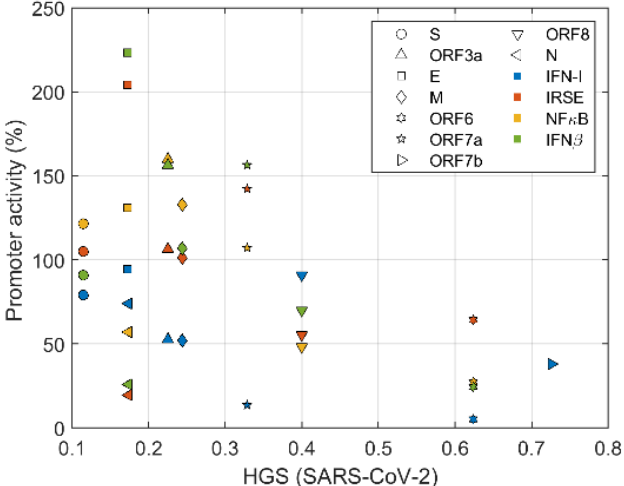
Figure 9. The SARS-CoV-2 escapes innate immunity by suppressing the expression of IFN- β , IFN-I, ISRE (indicating interferon synthesis) and NF κ B through ORF encoding accessory proteins. As the HGS of viral genes increase, the activity of IFN- β , IFN-I, ISRE, and NF κ B promoter decrease grad-